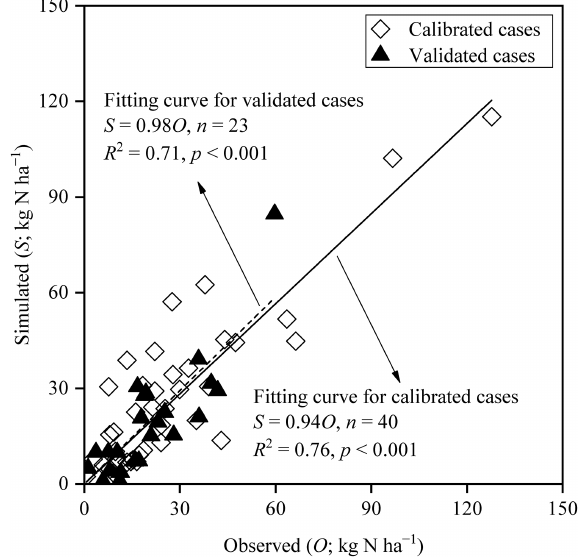
Figure 6. Comparison between the observed and simulated cumula- tive ammonia volatilization from the individual fertilization events across all calibrated and validated cases of upland and rice paddy fields; n , p , and R 2 denote the sample size, significance level, and coefficient of determination for the zero-intercept linear regression,